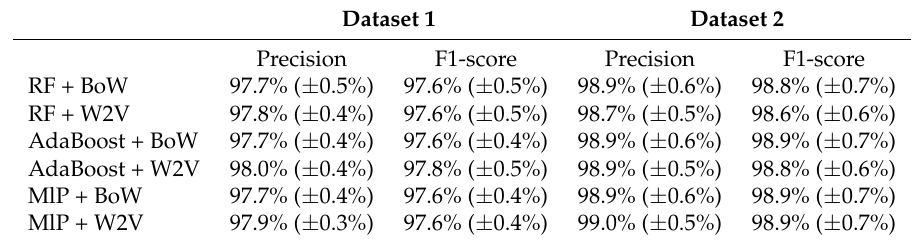
Figure 5. Cross validation values of the recall index for the prediction of the account codes (received invoices). Table 1. Mean cross validation precision and f1-score of the classifiers which predict account codes (sent invoices). Standard deviation is reported in